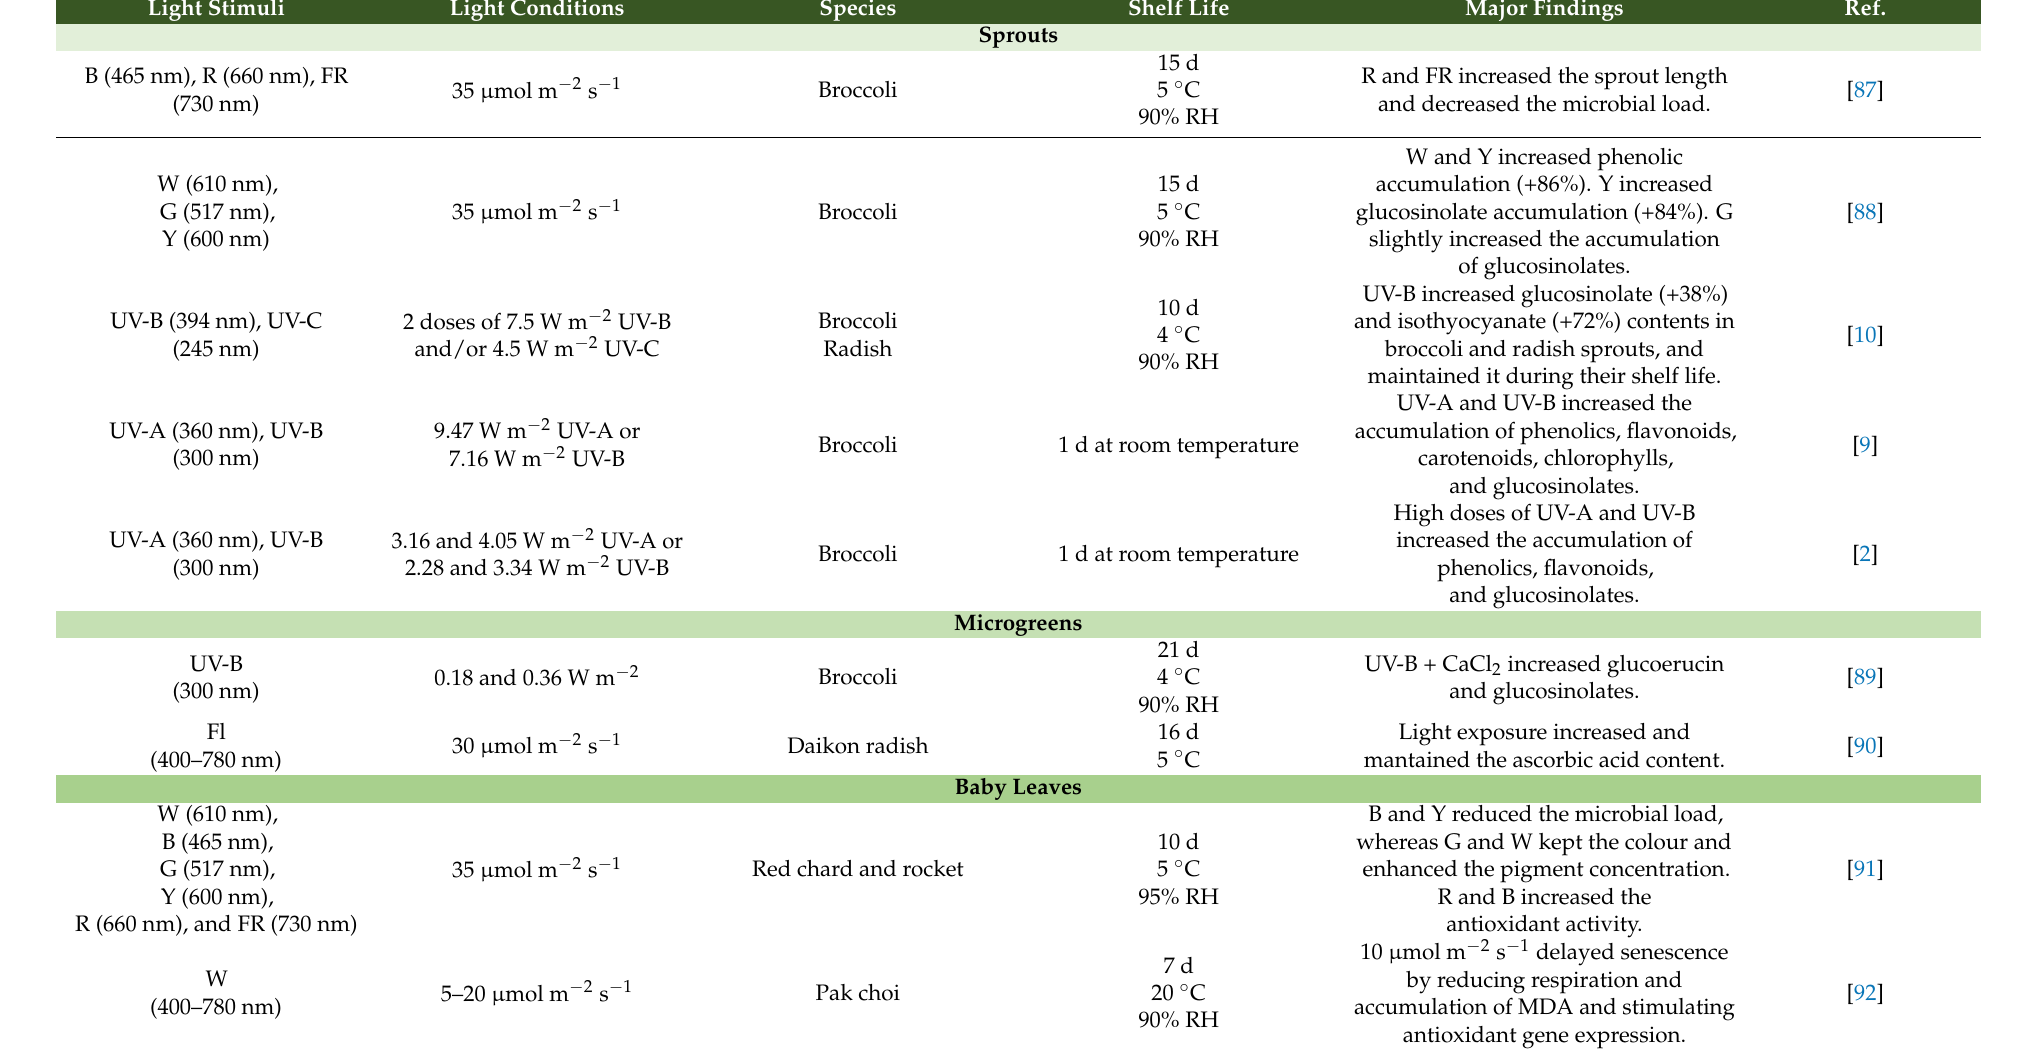
Table 2. Postharvest UV and visible spectrum lighting as elicitors of phytochemicals and preservative techniques for sprouts, microgreens, and baby